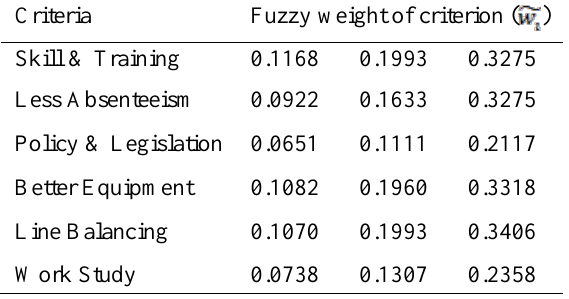
Table 4. Relative fuzzy weight of each